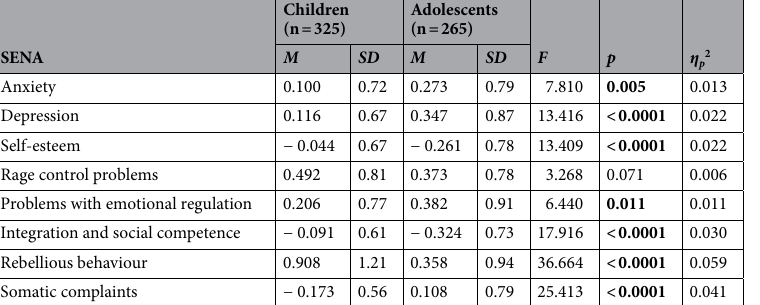
Table 3. Differences in the state of mental health between children and adolescents during confinement. Statistically significant differences ( p < .05) are highlighted in bold